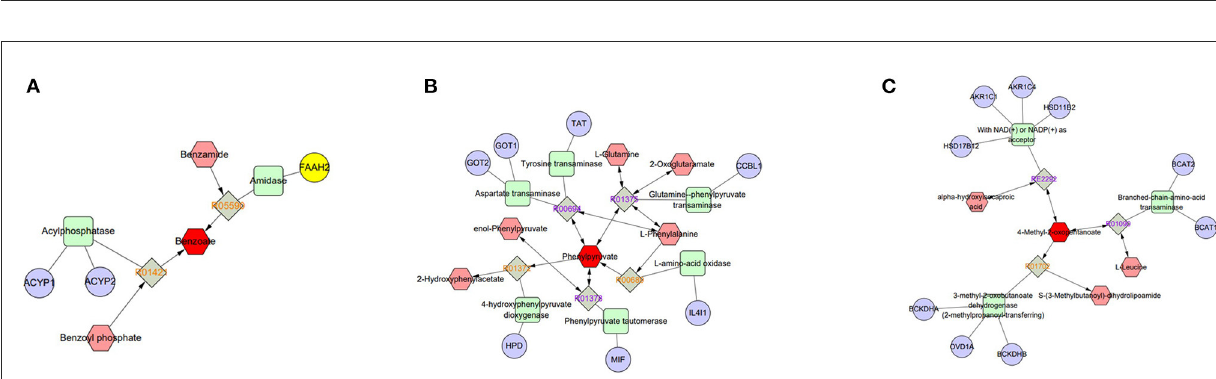
freezability, including the ability of PC to affect sperm motility and fertilization ability (20, 58, 59). PC is a major component of cryoprotectants during the semen cryopreservation process of